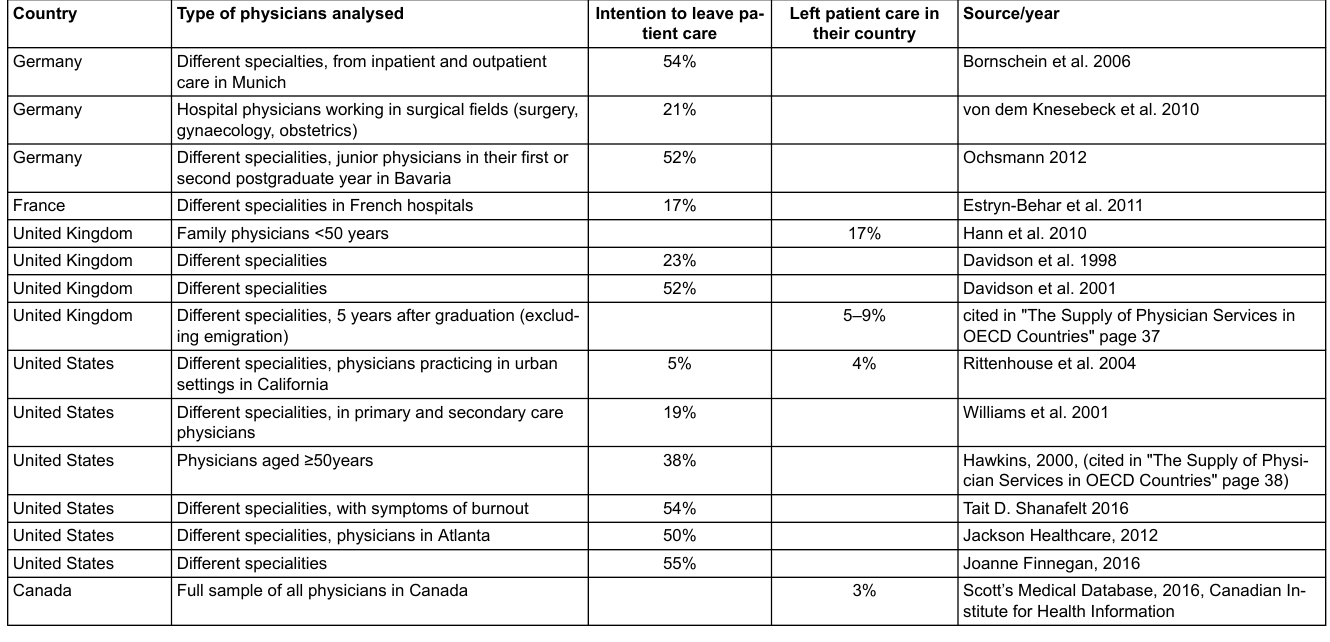
Table 3: Intention and effectively leaving patient care in different samples of physicians across countries. Country Type of physicians